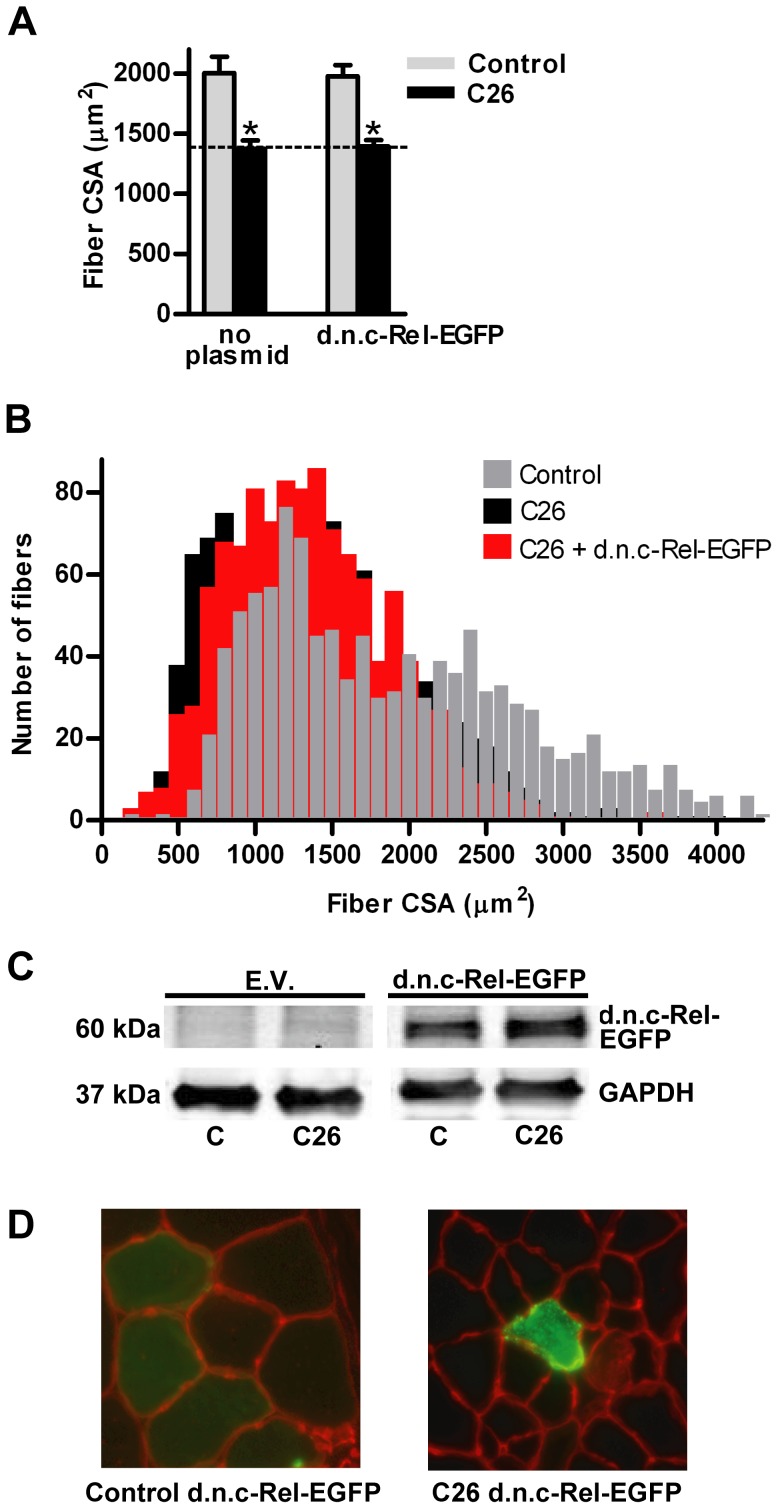
Effects of d.n. c-Rel-EGFP on muscle fiber cross sectional area (CSA).(A) Mean tibialis anterior (TA) fiber cross-sectional area in control and C26 tumor-bearing mice in the presence or absence of d.n. c-Rel-EGFP. Each bar represents mean fiber area from 8 muscles (± SE). (B) Fiber area frequency distribution of all fibers from muscles of control, C26, and C26 + d.n. c-Rel-EGFP groups. (C) Western blots of lysates from TA muscles injected with the empty vector (EV) or d.n. c-Rel-EGFP plasmid confirms overexpression of the fusion protein. d.n.c-Rel-EGFP is 60 kDa. All samples are from the same immunoblot. (D) Representative cross sections of TA muscles from control and C26 tumor-bearing mice injected with the d.n.p65-EGFP plasmid. C  =  control. * significantly different from control (P<0.05).